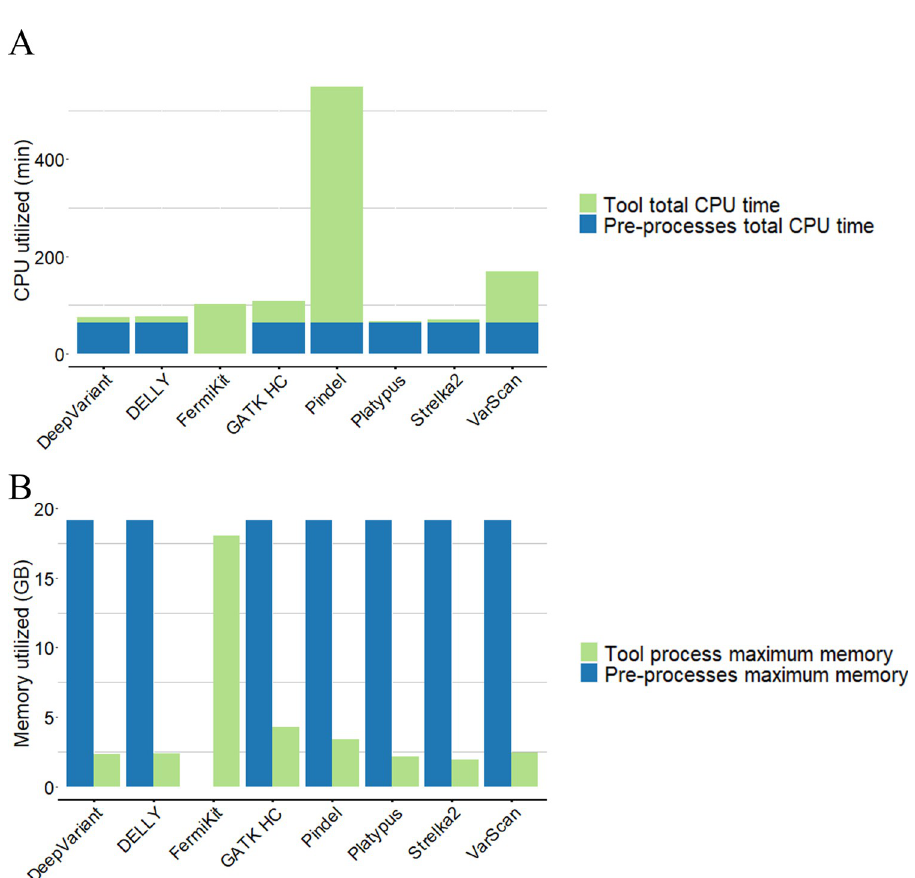
Fig 9. The running times and the maximum memory usages of variant calling tools. A) Total CPU times of each variant calling tool with 30 × coverage, 250bp read length semi-simulated sequencing data. The total CPU time of pre- processing included aligning the sequencing reads into the BAM file. Tool total CPU time included analyzing the input BAM file into the output VCF format result. (B) Maximum memory usage of each variant calling tool with 30 × coverage, 250bp read length semi-simulated sequencing data. Maximum memory of pre-processing included aligning the sequencing reads into the BAM file. Tool maximum memory usage included analyzing the input BAM file into the output VCF format result. Because FermiKit is a de novo assembly algorithm-based variant calling tool, which took sequencing reads as input, it did not require pre-processing.